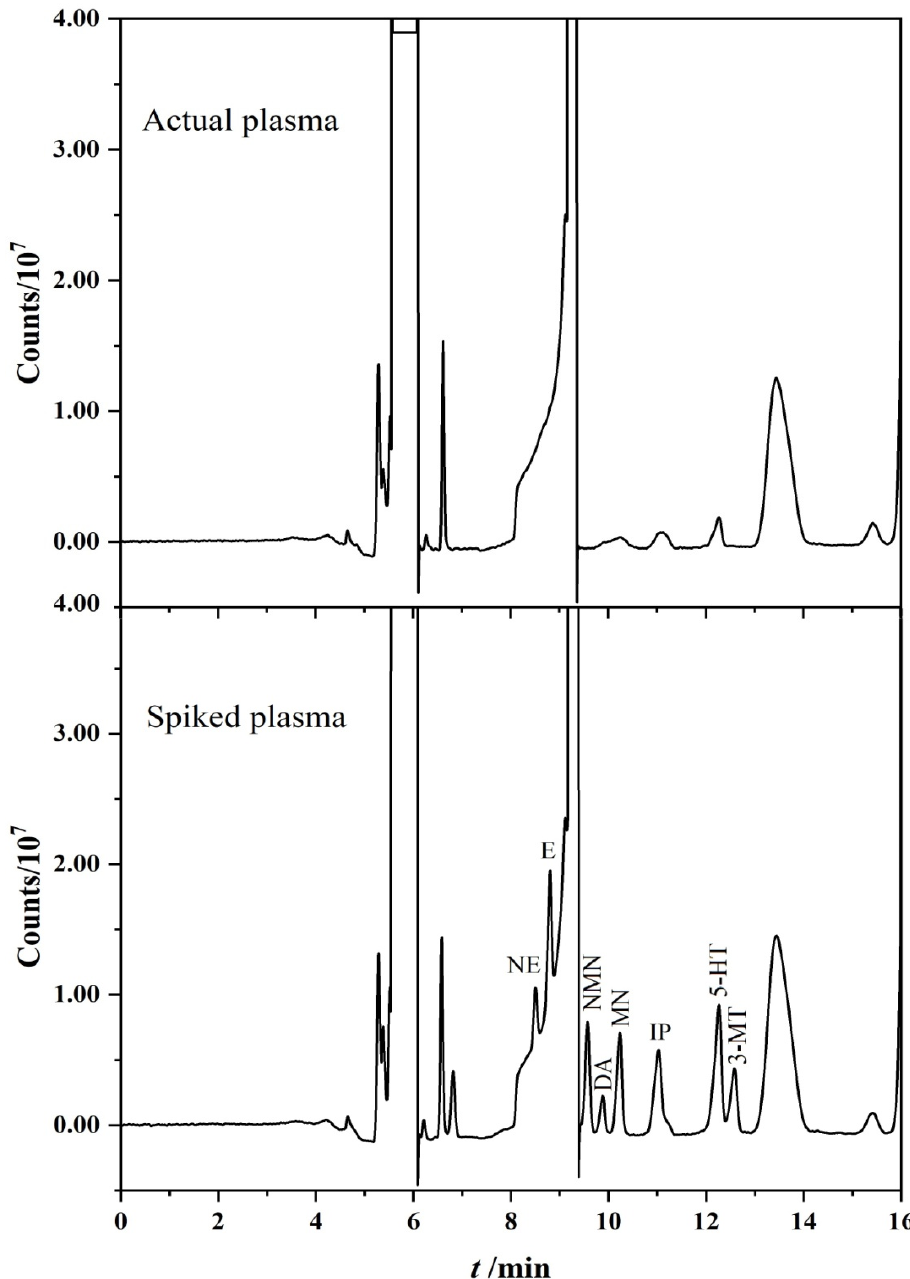
Figure 5. Chromatograms of spiked plasma (100 ng/mL) and actual plasma using on-line PFSPE– HPLC method.